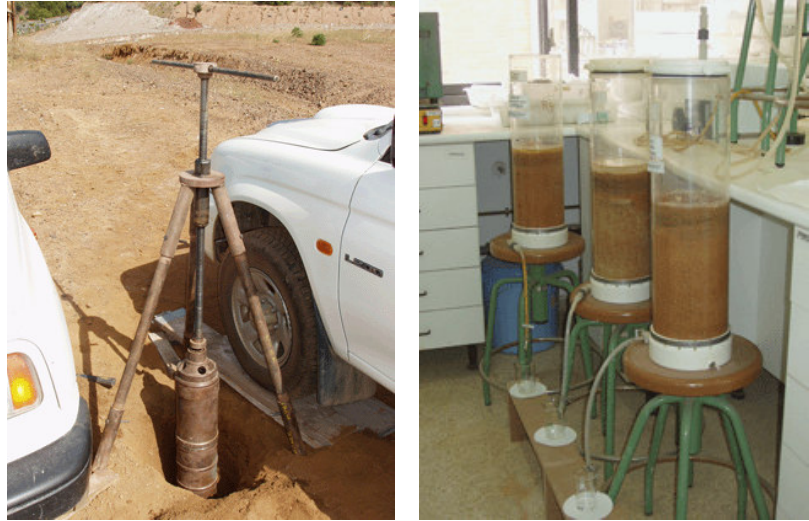
FIGURE 4. (Left) The system used for obtaining of undisturbed soil columns; (right) column leaching